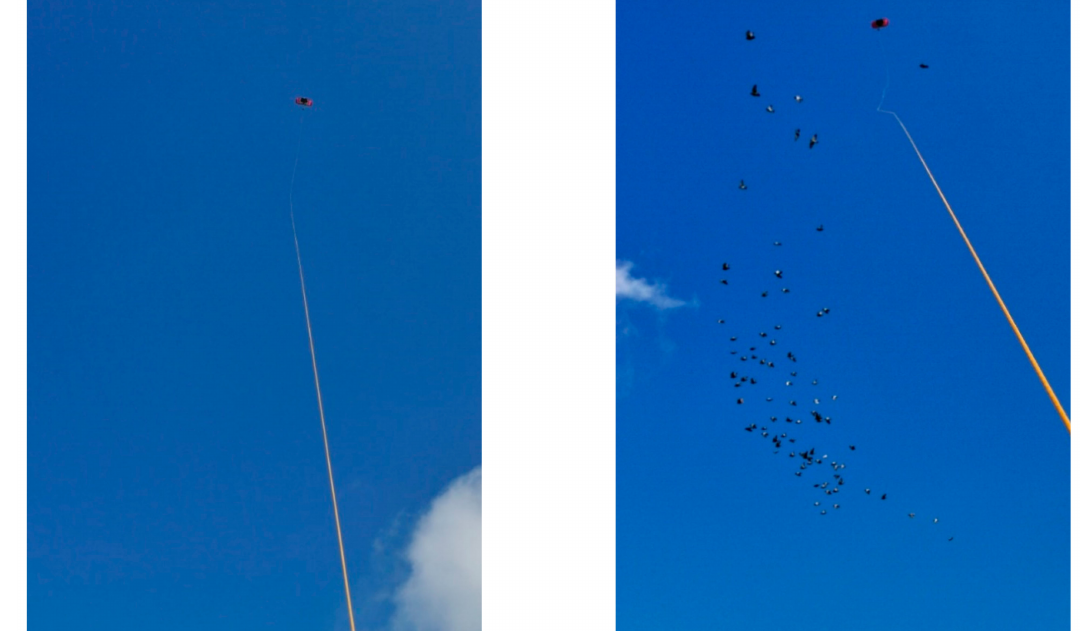
Figure 5. Pilot operation of the 20 kW kite power system of TU Delft [88] before ( left ) and after a bird collided with the tether ( right ). The bird continued the flight seemingly unaffected, which suggests that bird collisions with a tether are possible but do not necessarily have to be fatal. Max Dereta took the photos on 28 June 2011 at Valkenburg airfield, The